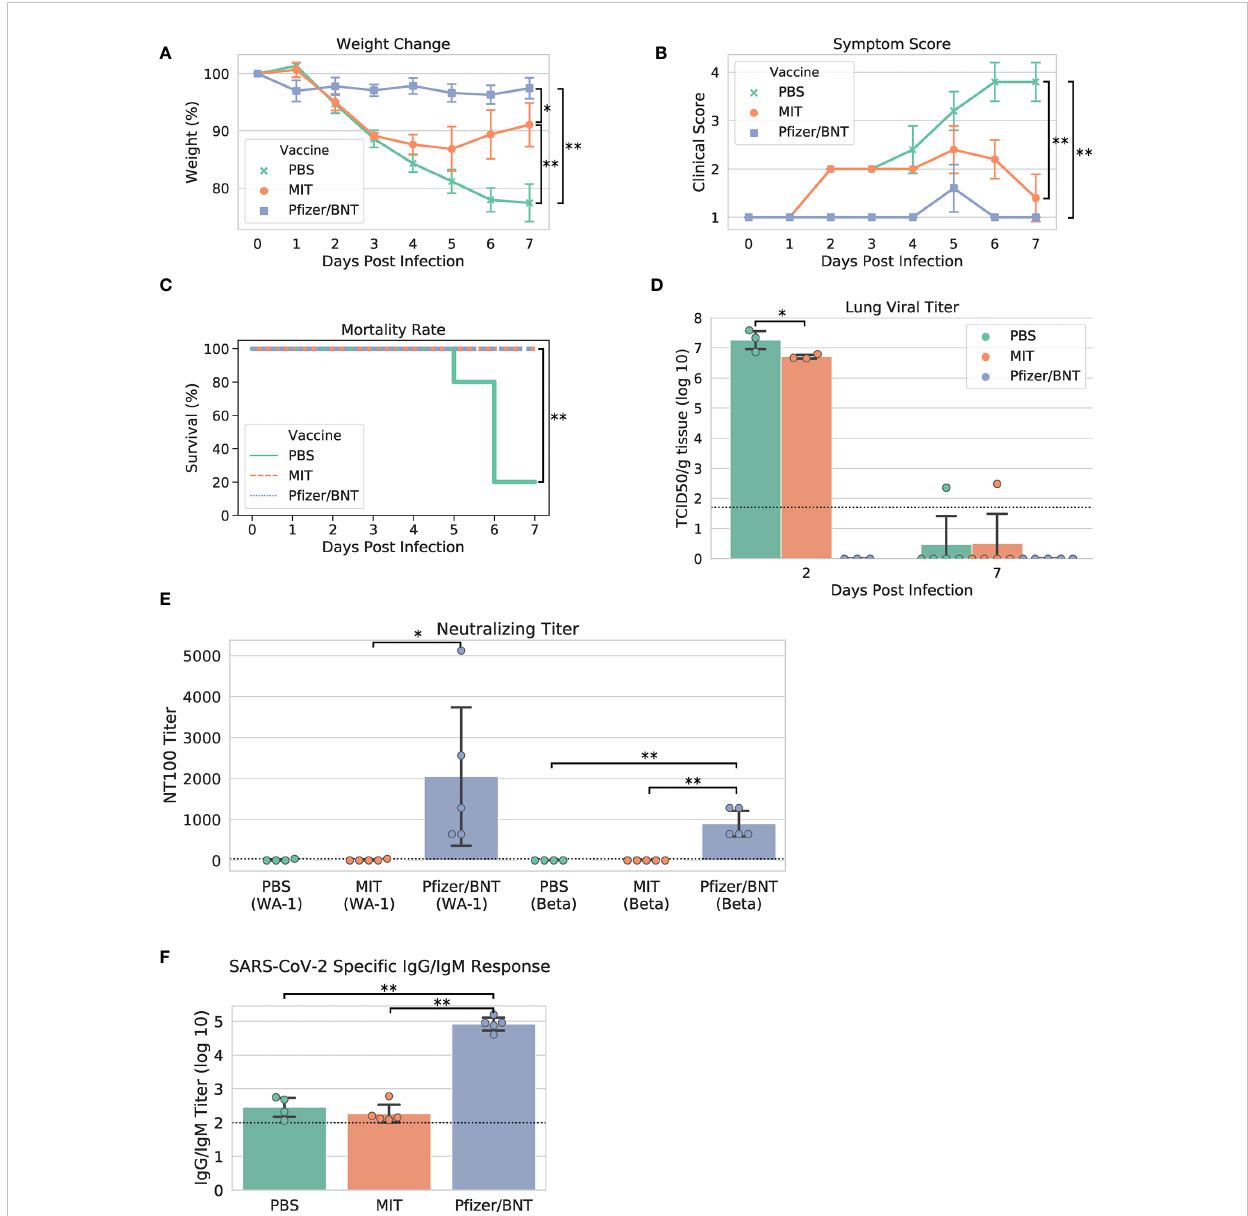
FIGURE 3 Study phenotypic data, lung viral titer, and vaccine antibody responses. (A) Weights vs . days post infection, (B) clinical scores vs . days post infection, (C) Kaplan-Meier mortality curve (mortality at 80% weight loss), (D) lung viral titer, (E) maximum serum dilution that provided 100% neutralization of viral infection in vitro , (F) IgG/IgM titer measured by ELISA against cell lysate infected with WA-1 SARS-CoV-2. Dotted lines in (D – F) indicate assay limits of detection. Error bars indicate the standard deviation around each mean. P values were computed by one-way ANOVA with Tukey ’ s test except (C) P values were computed using the logrank test. * P < 0.05 and ** P <